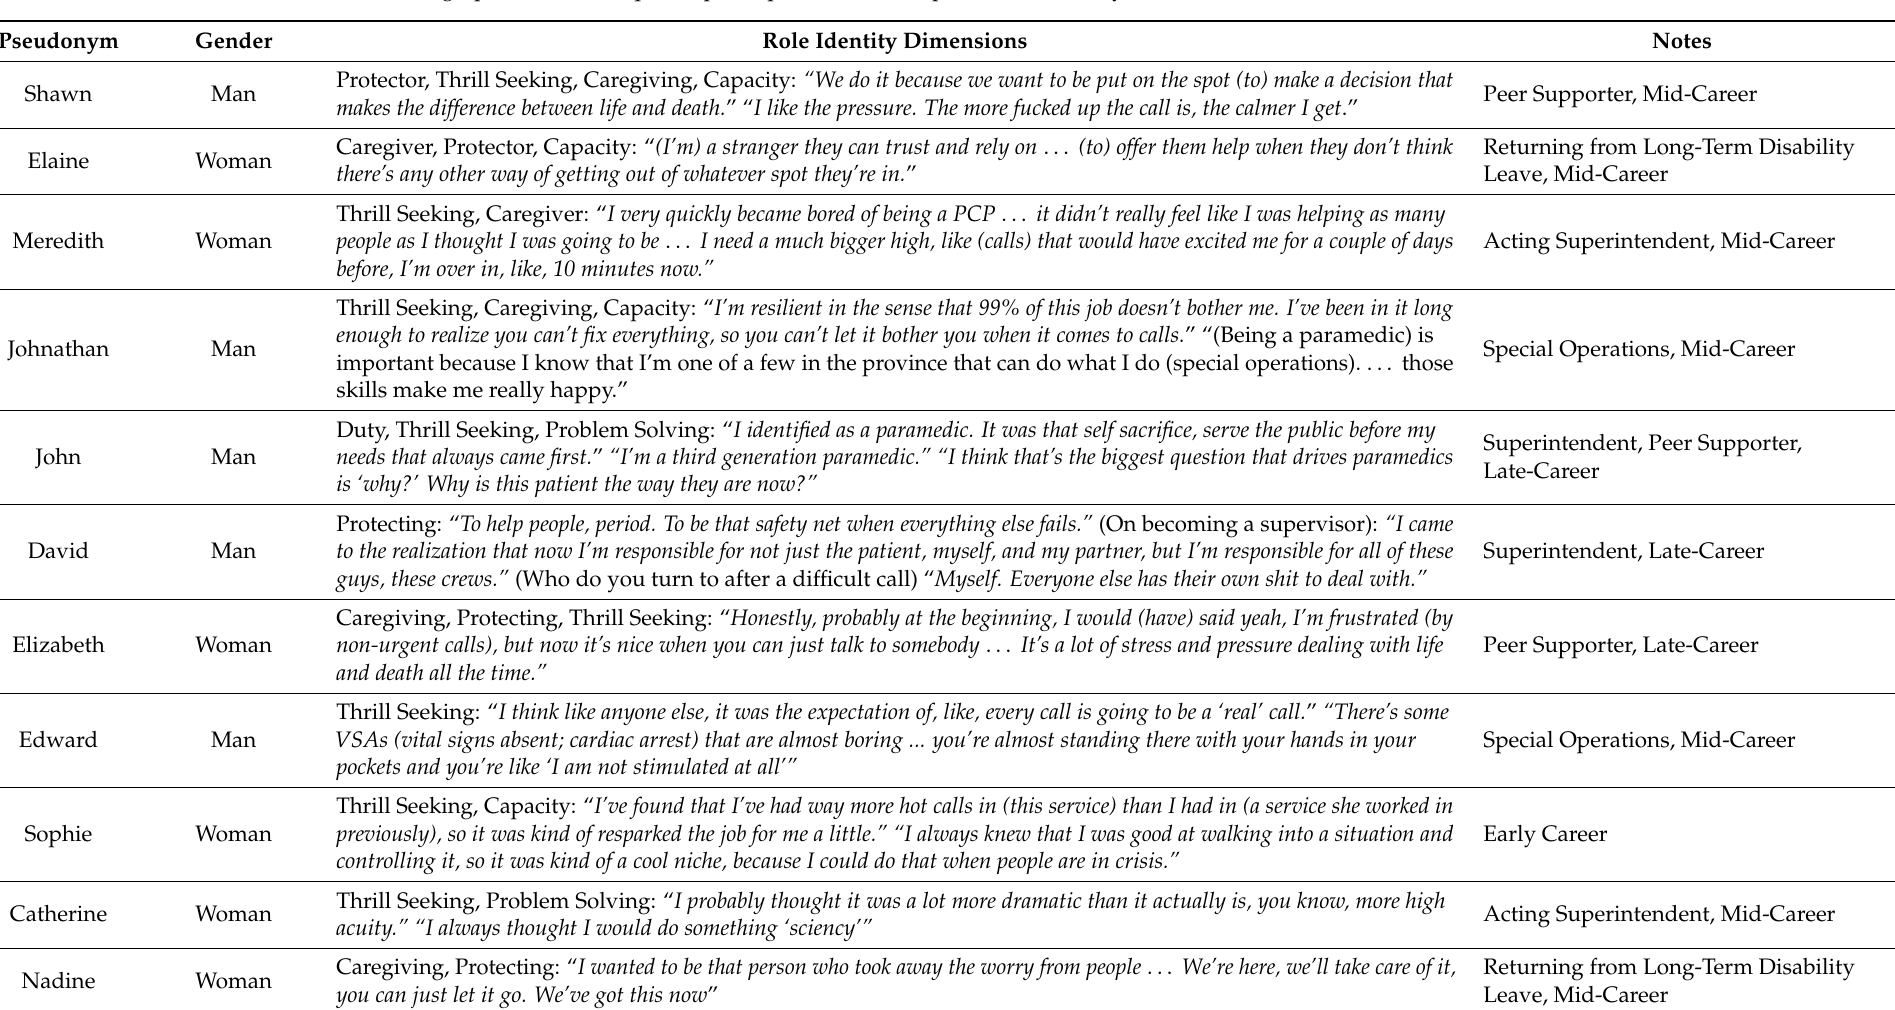
Table 1. Demographic details for quoted participants with examples of role identity